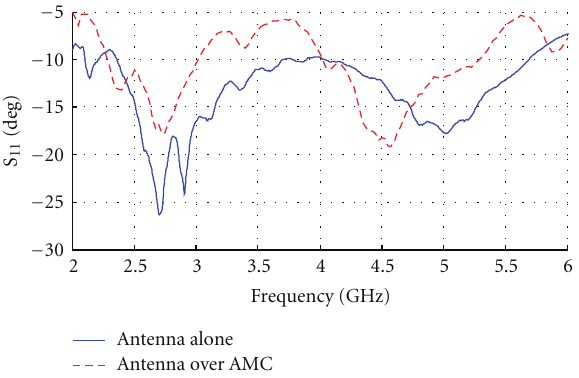
Figure 15: Simulated and measured return loss for the CPW-fed broadband monopole antenna on felt.